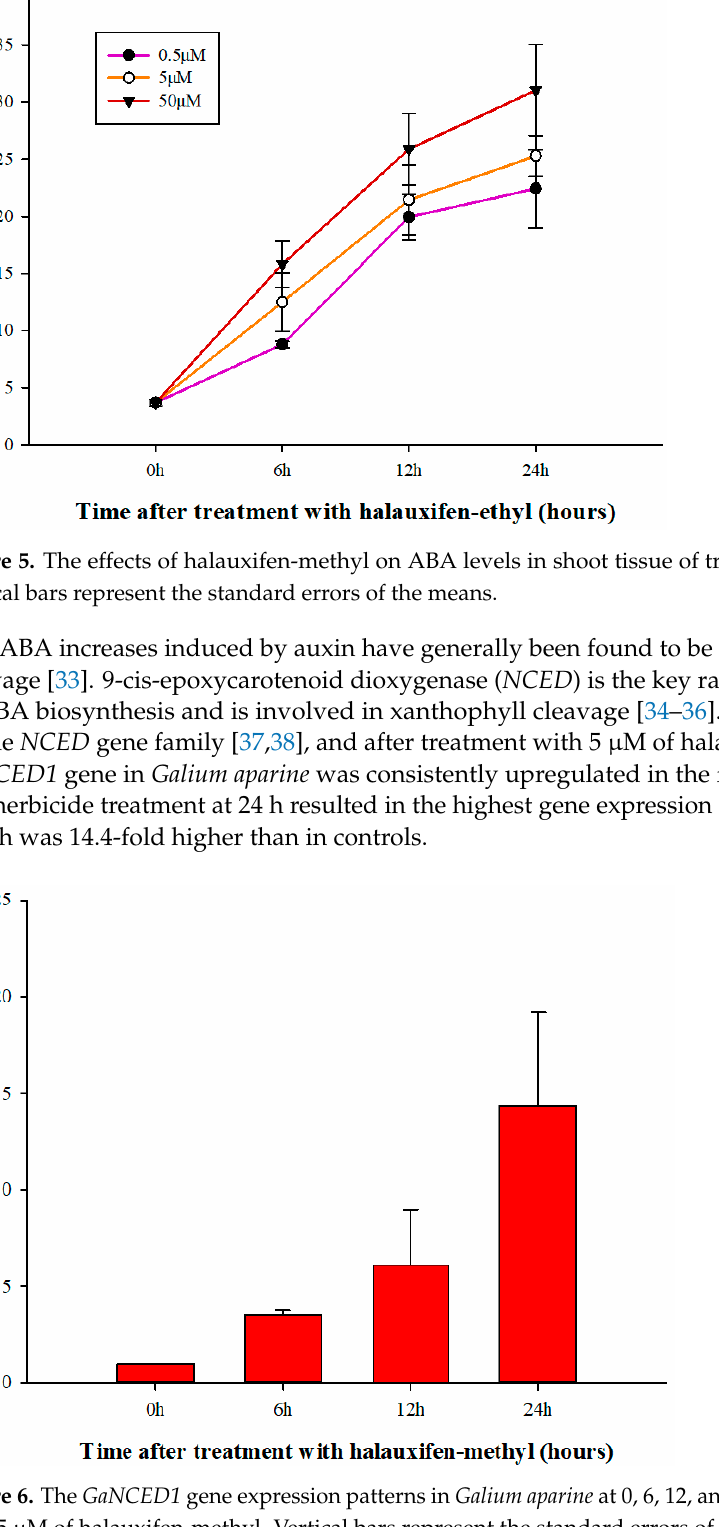
Figure 4. The GaACS4 and GaACS7 gene expression patterns in G. aparine at 0, 6, 12, and 24 h after treatment with 5 μ M of halauxifen-methyl. Vertical bars represent the standard errors of the means.